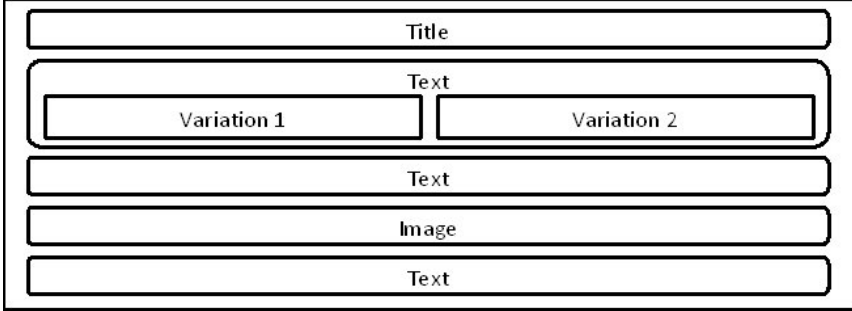
Figure 2. Example of chapter’s